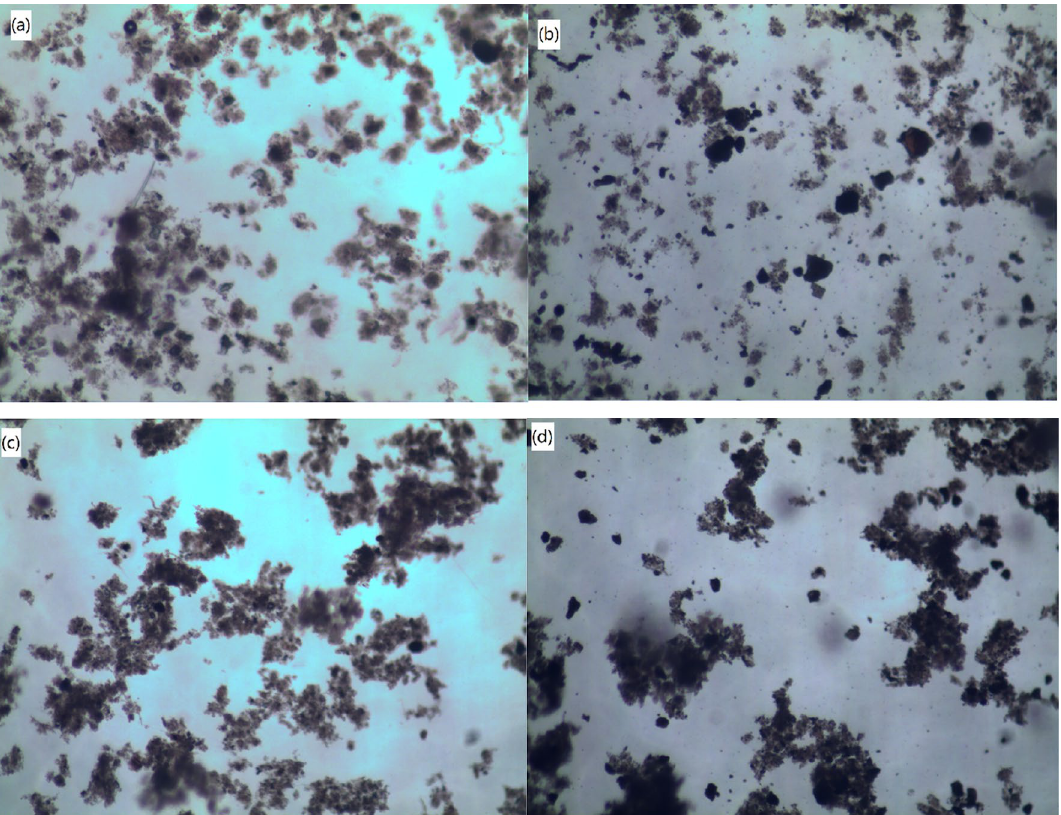
Figure 5. Optical microscope images of sludge flocs: ( a ) raw sludge and conditioned by ( b ) ATP, ( c ) St-CTA, and ( d ) St-CTA in conjunction with ATP at respective optimal dose, that is, St-CTA is 16.00 mg/gTSS and ATP is 14.00 kg/m 3